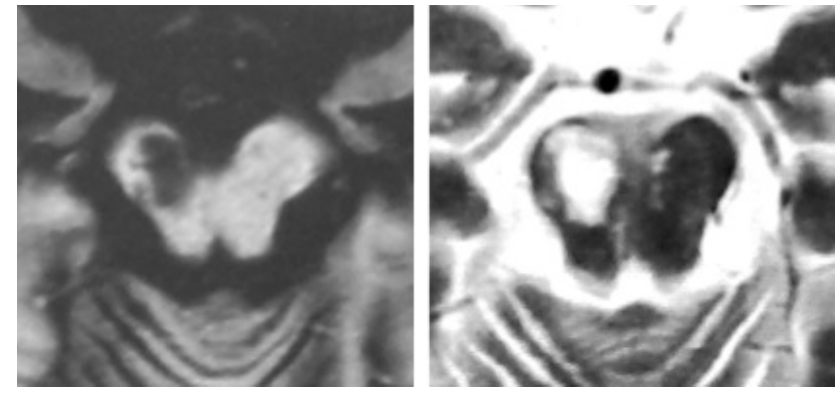
Figure 1. A brain MRI was performed with a 3.0 T system (Achieve; Philips Medical Systems, Eindhoven, The Netherlands) using a standard head coil. A T1-weighted inver- sion recovery (TE/TR= 2000/20msec, TI=900msec) image showed a hypo intensity lesion in the medial midbrain (left) and the lesion showed high intensity in a T2-weighted spin echo (TE/TR= 4931/80msec) image